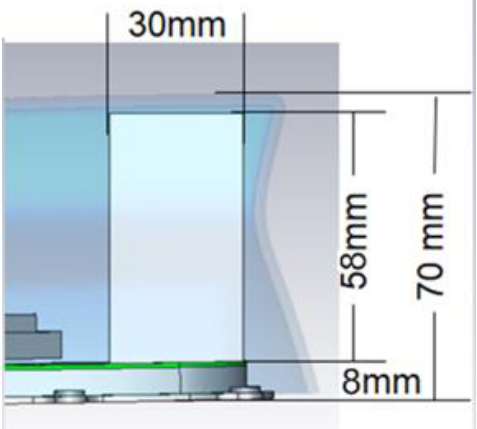
Figure 1. Vehicle shark fin rear-section to illustrate antenna size constraint.